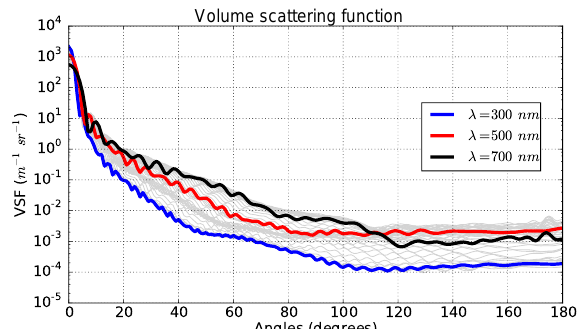
Figure 17. Volume scattering function obtained using the Bernard model combined with the genetic algorithm for cylindrical-shaped